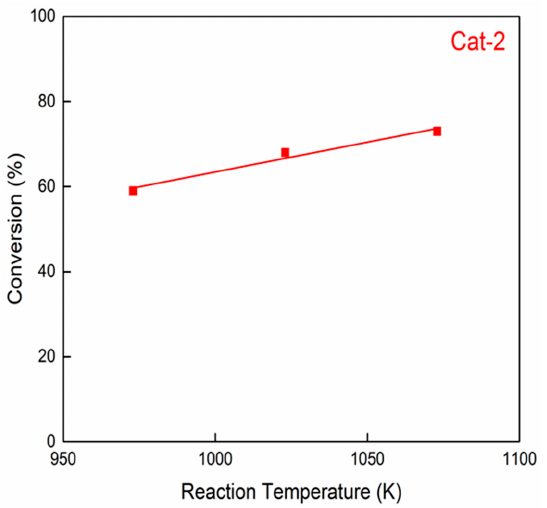
Figure 5. The effect of TCD temperature on methane conversions (973–1073 K, 1 bar, gas velocity 18 K mL g − 1 h − 1 ).